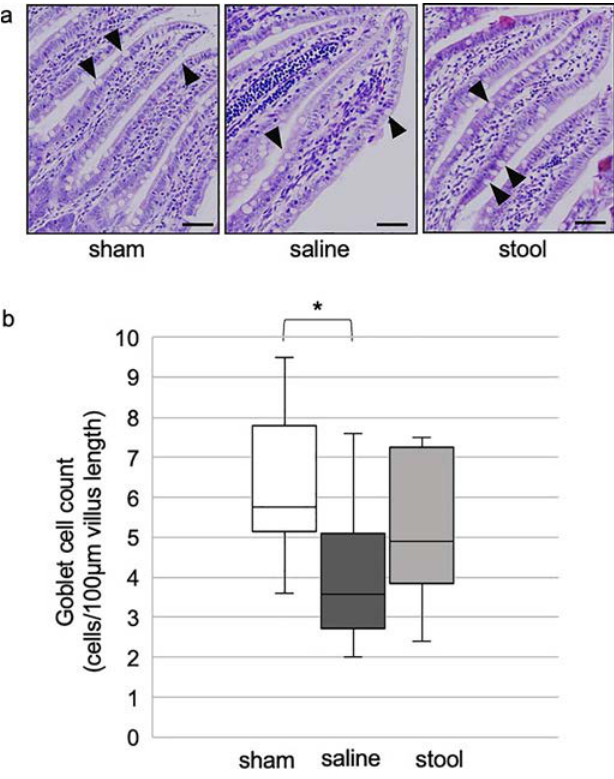
Figure 4 Numbers of goblet cells in experiment 2 a) H&E stained distal ileum from sham, saline, and stool groups in experiment 2 (arrowheads=goblet cells) (scale bar=50 mm). b) Quantitative analysis with Kruskal–Wallis test (median from four villi of each rat, n=3). * P